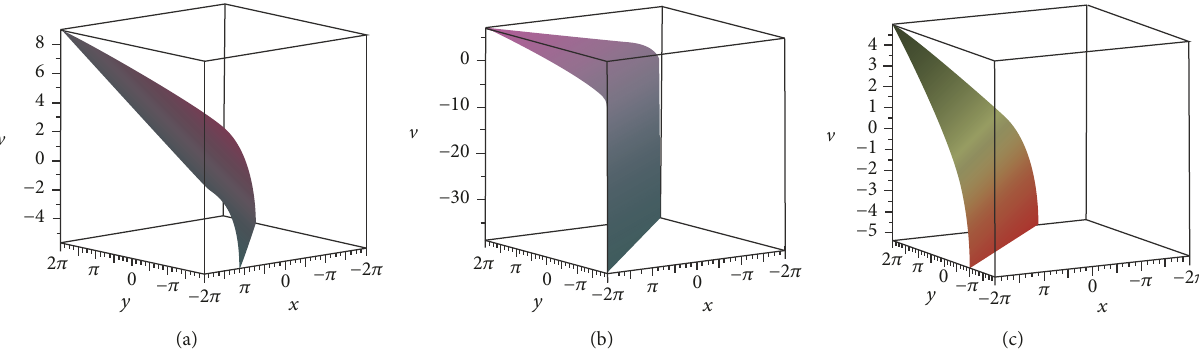
Figure 4: The solution of the (2 + 1)-dimensional Jaulent-Miodek equation corresponding to V 𝑠,1 (𝑧) , (a) 𝑡 = −5 , (b) 𝑡 = 0 , and (c) 𝑡 = 5